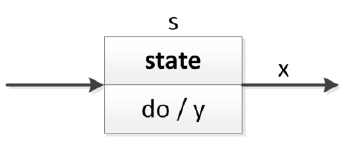
Figure 2. A state in the UML state machine diagram with input and output signals.